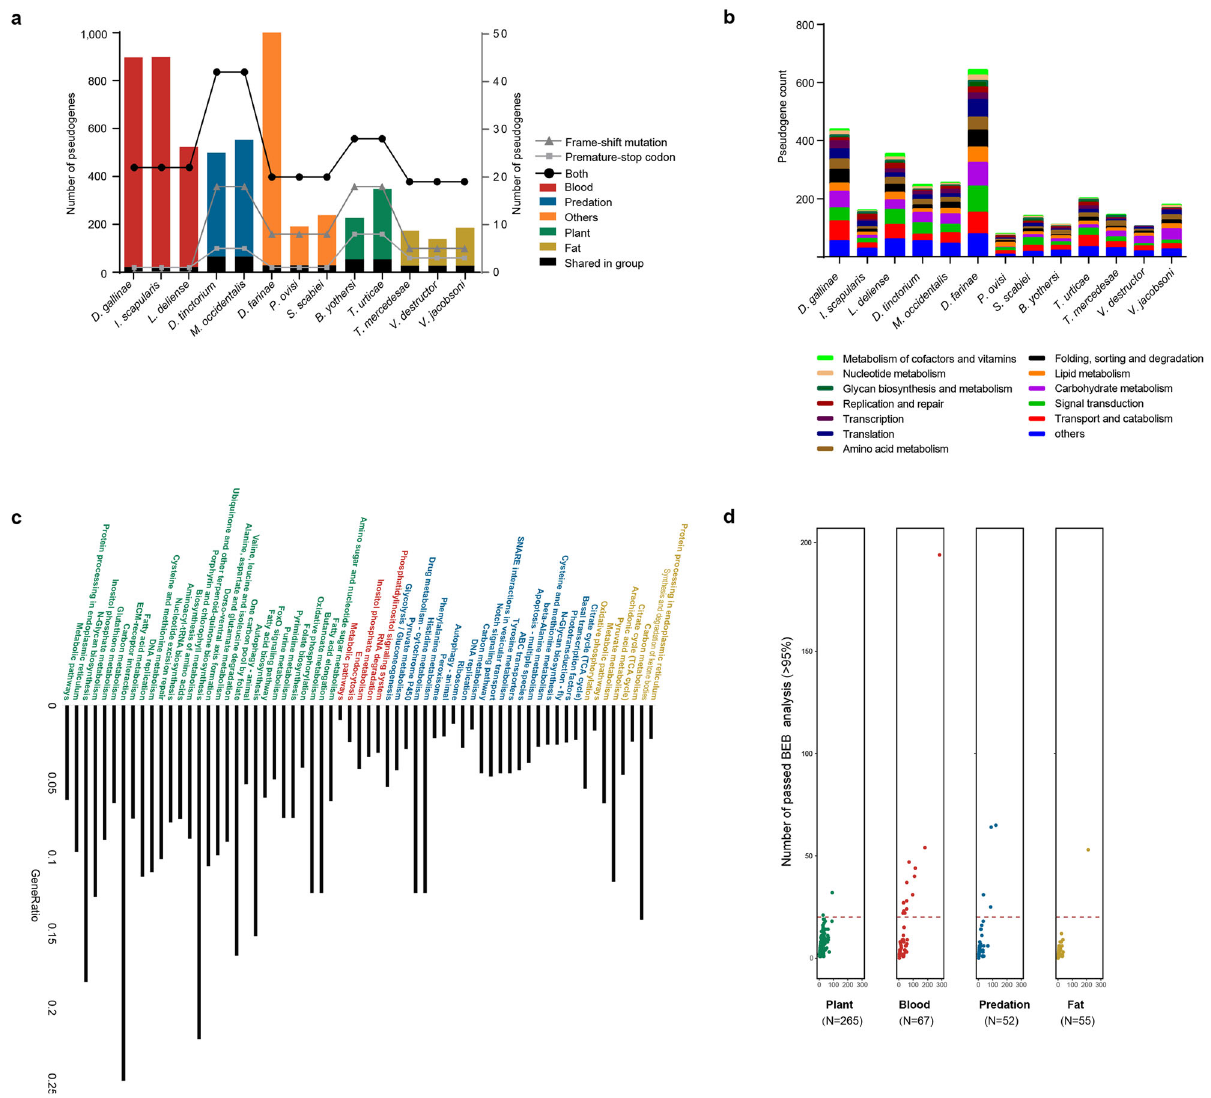
Fig. 2 Pseudogene and PSG pro fi les of different dietary groups. a The overall numbers of pseudogenes detected in each group are shown in different colours reference to left y-axis, and the numbers of shared pseudogenes in each group are shown in black. The pseudogenes in each group are divided into three types, namely, frame-shift mutation, premature-stop codon, and both, and the ratios of types are displayed by lines reference to right y-axis. b The functional classi fi cation of the pseudogenes in each group. c KEGG enrichment analysis of the PSGs. d PSGs generated by the orthologous genes annotated in at least two species in each dietary group. The number in parentheses represents the number of PSGs in the group. The dot plot shows the numbers of positively selected sites across four different dietary groups. The x-axis indicates the number of loci detected as being under selection pressure, and the y- axis indicates the number of positively selected loci with a BEB posterior probability greater than 95% in PAML. PSG positively selected gene, KEGG Kyoto Encyclopedia of Genes and Genomes, BEB Bayesian empirical